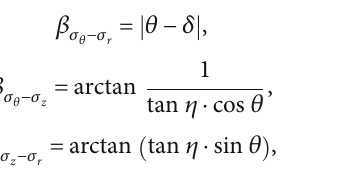
Figure 4: The variation of σ caved rocks by laboratory